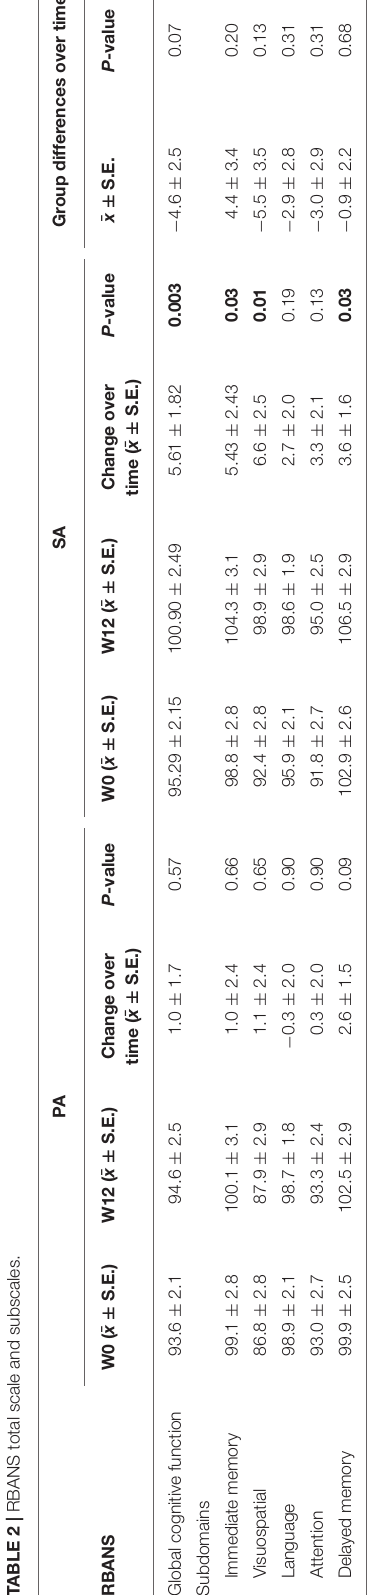
TABLE 1 | Baseline participant